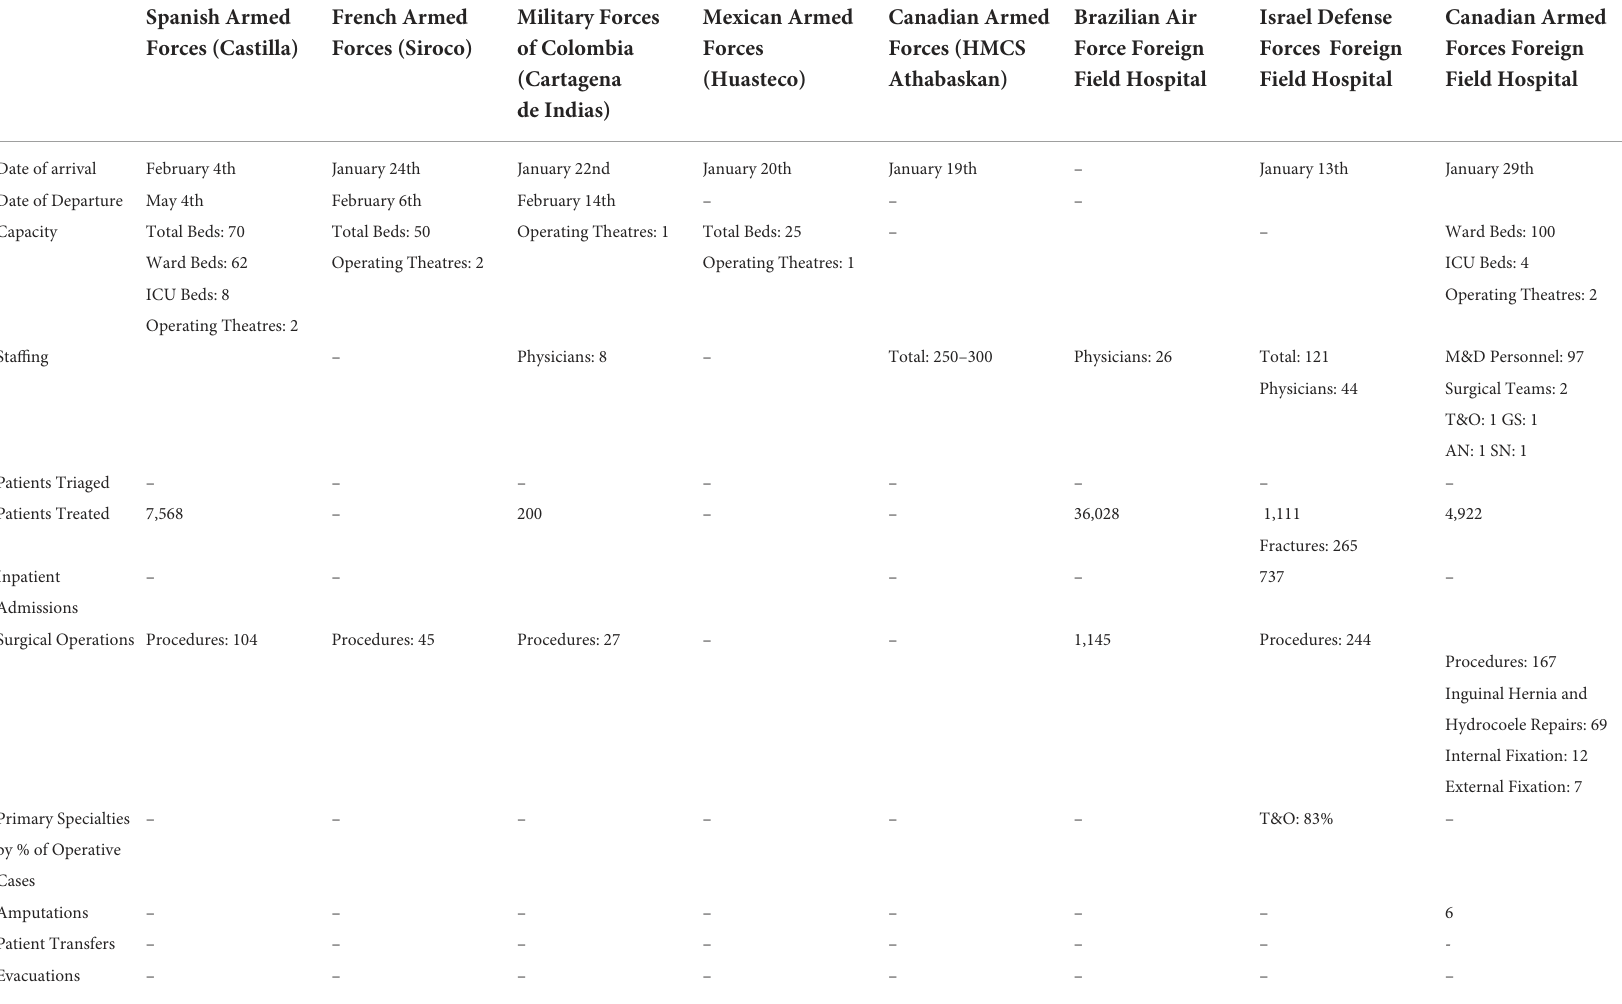
TABLE 7 Summary of healthcare operations: international military